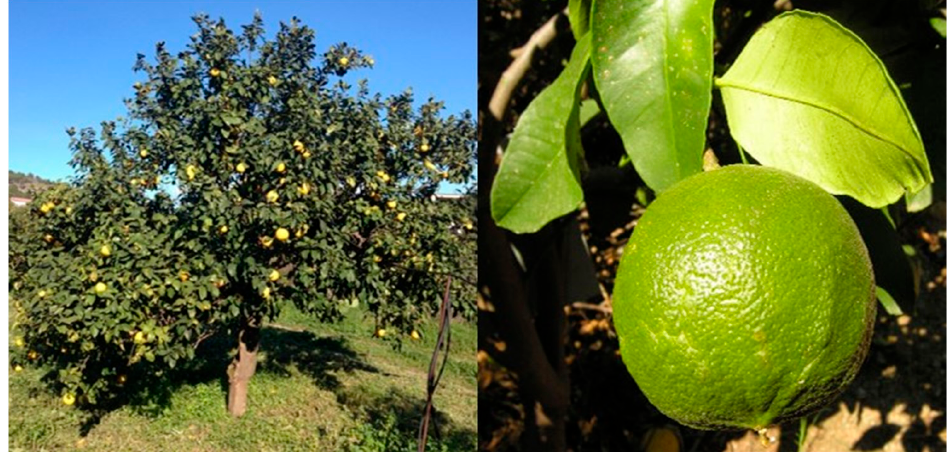
Figure 1. Citrus bergamia Risso et Poiteau.